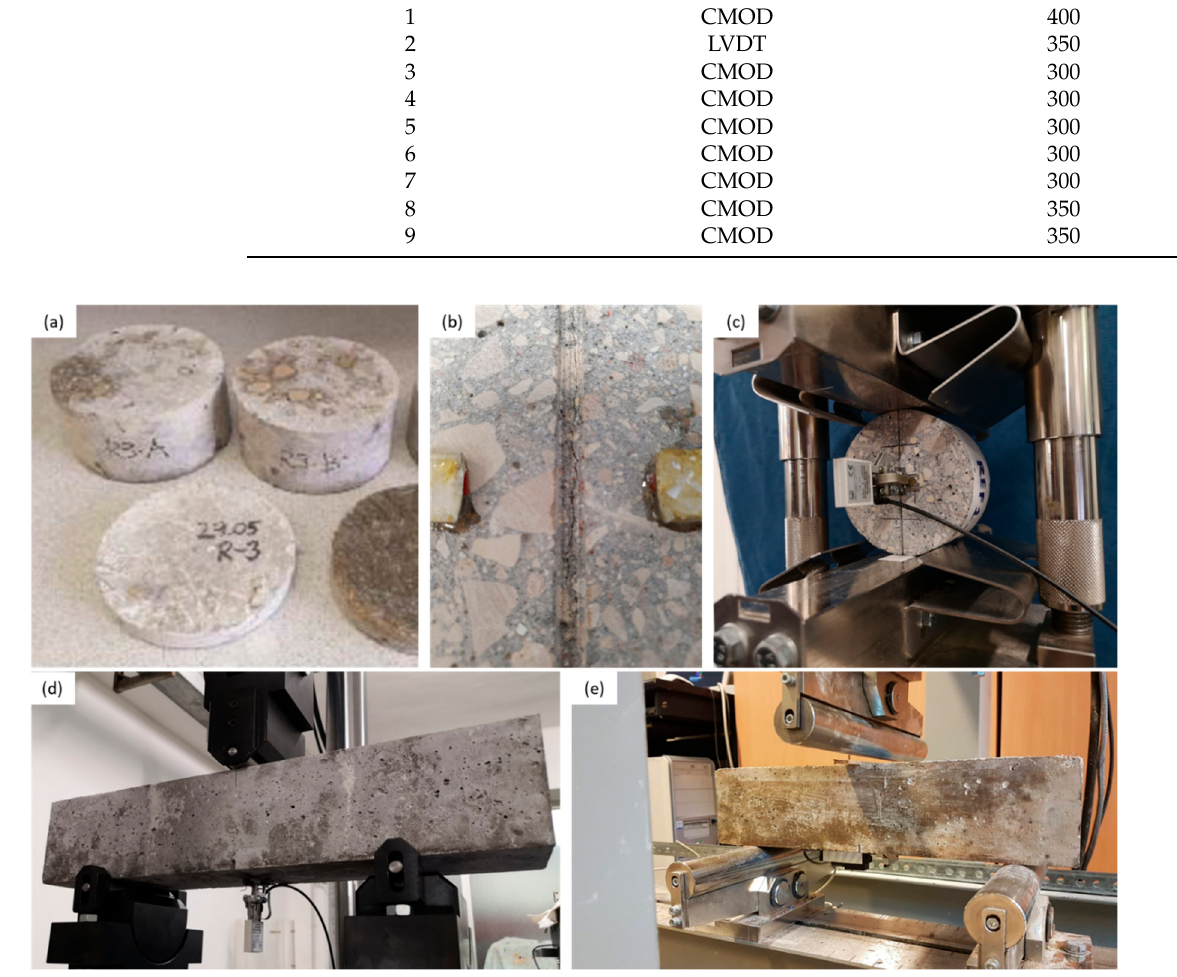
Figure 2. Sample preparation of specimen for testing (( a ) discs extracted from cylinders; ( b ) notches created on either side of discs; ( c ) example of testing setup for cracking for crack control) with different closed-loop feedback systems for cracking of prism specimen; ( d ) CMOD control; and ( e ) LVDT control).